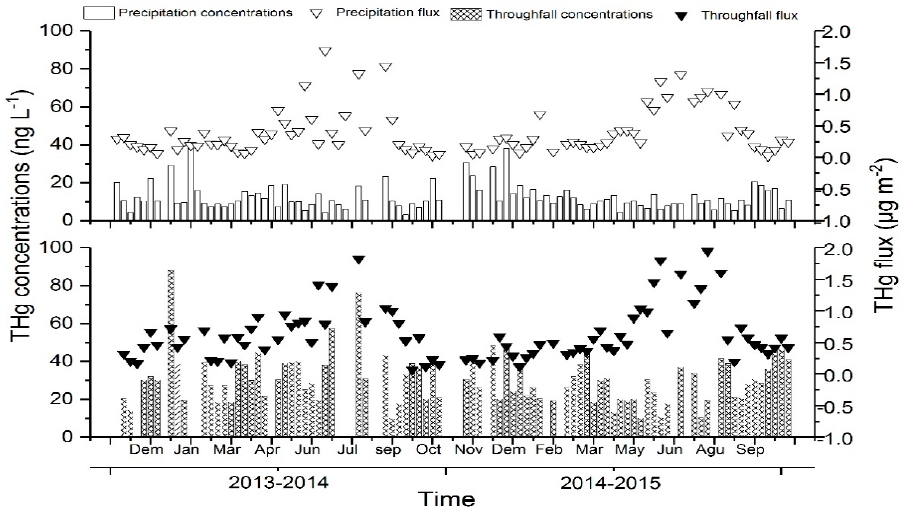
Figure 2. THg concentrations and fluxes in the precipitation and throughfall collected in the study forest stand from 2013 to 2015.